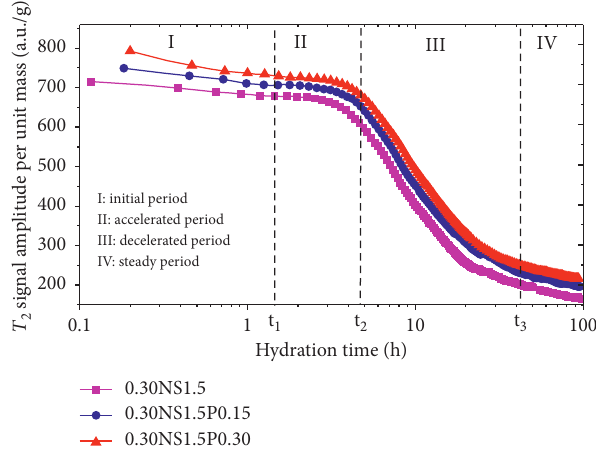
Figure 6: Effects of different SAP contents on the hydration